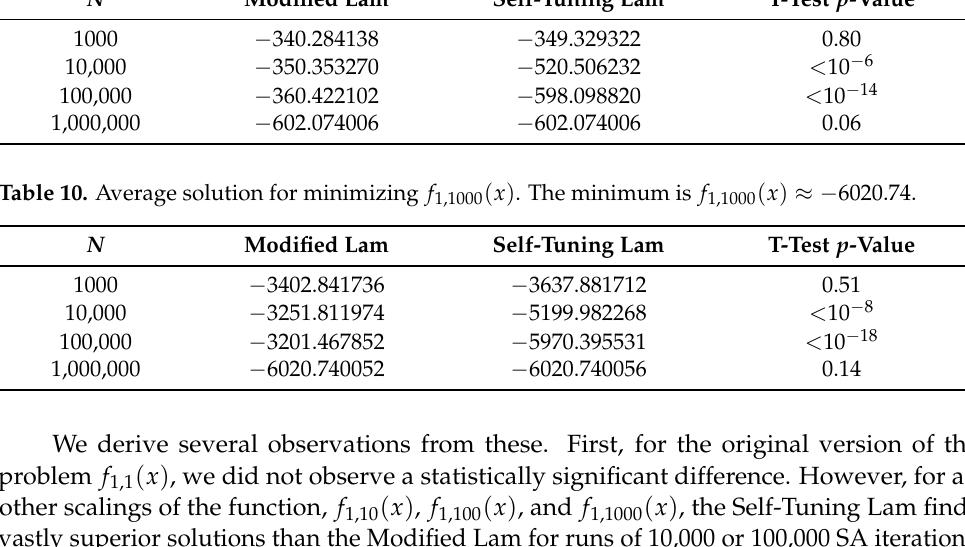
Table 9. Average solution for minimizing f 1,100 ( x ) . The minimum is f 1,100 ( x ) ≈ − 602.074. N